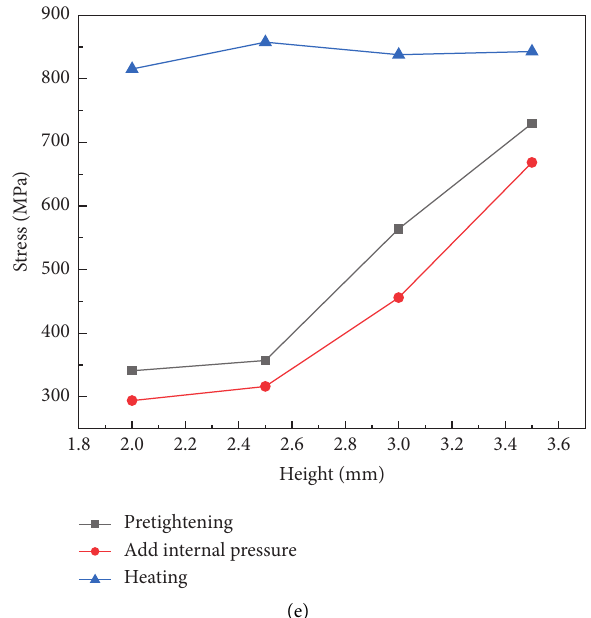
Figure 21: Contact pressure trends of various corrugations in different states in regard to height. (a) Corrugation A. (b) Corrugation B. (c) Corrugation C. (d) Corrugation D. (e) Corrugation